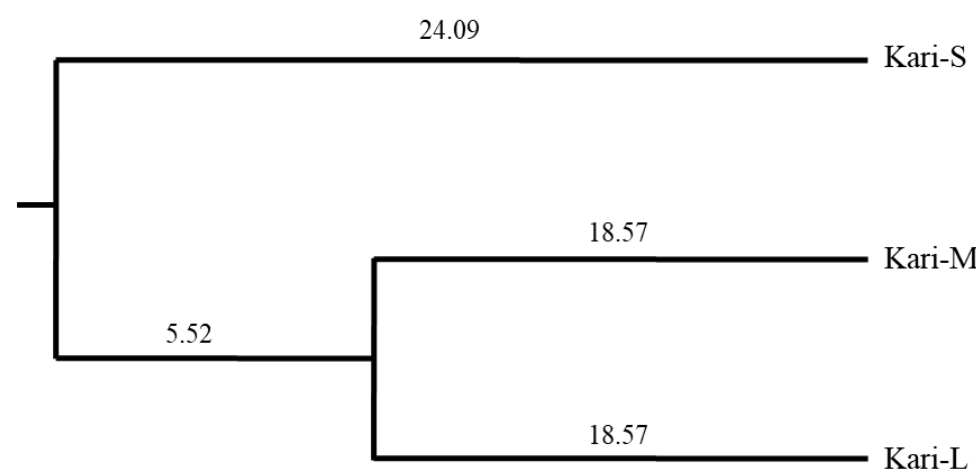
Figure 4. Dendrogram based on Nei’s unbiased genetic distance using the neighbor-joining method. The STRUCTURE analysis grouped different subtypes in inferred clusters (at the given K value) based on the allele frequency data at each locus (Figure 5). At K = 2, the Kari-S individuals were grouped in a separate cluster, while Kari-M and Kari-L shared one cluster with some admixture from Kari-S. This distinct clustering of Kari-S persisted at K = 3. Kari-M and Kari-L also made distinct clusters at K = 3; however, the clusters made by these two Kari subtypes showed an admixed ancestry. Only 75 and 59% of individuals from the Kari-M and Kari-L subtypes, respectively, clustered into separate inferred groups of the two